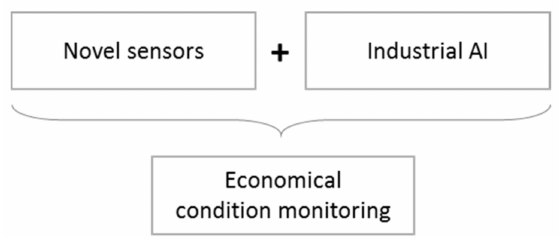
Figure 2. Novel sensors combined with industrial artificial intelligence methods can lead to more economical condition monitoring